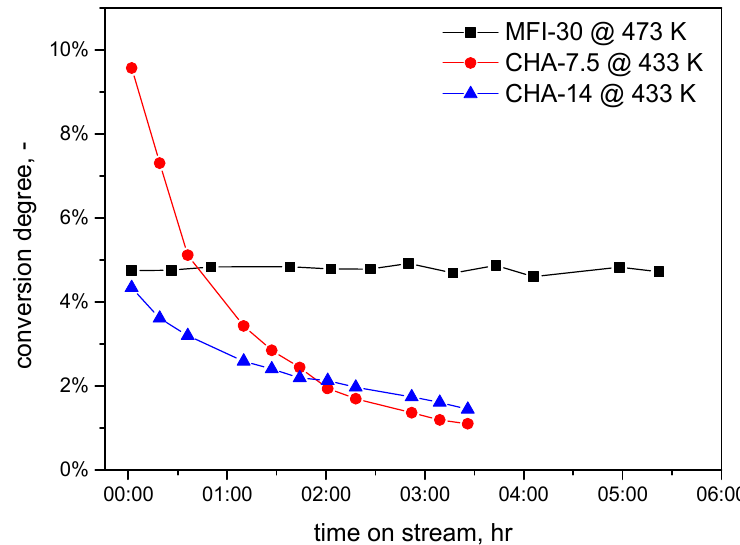
Figure 2. Catalytic ethanol dehydration TOS stability over all samples for 10% of ethanol in reaction stream.